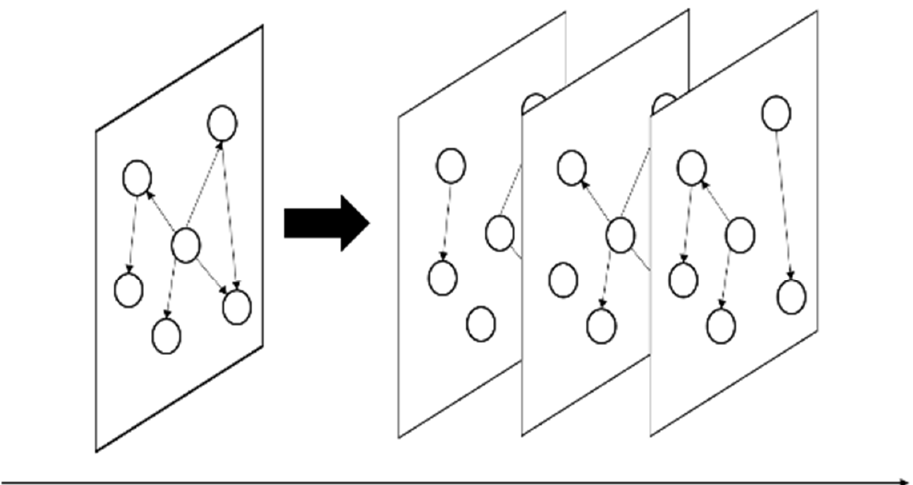
Figure 1. An example of a time-series knowledge graph.